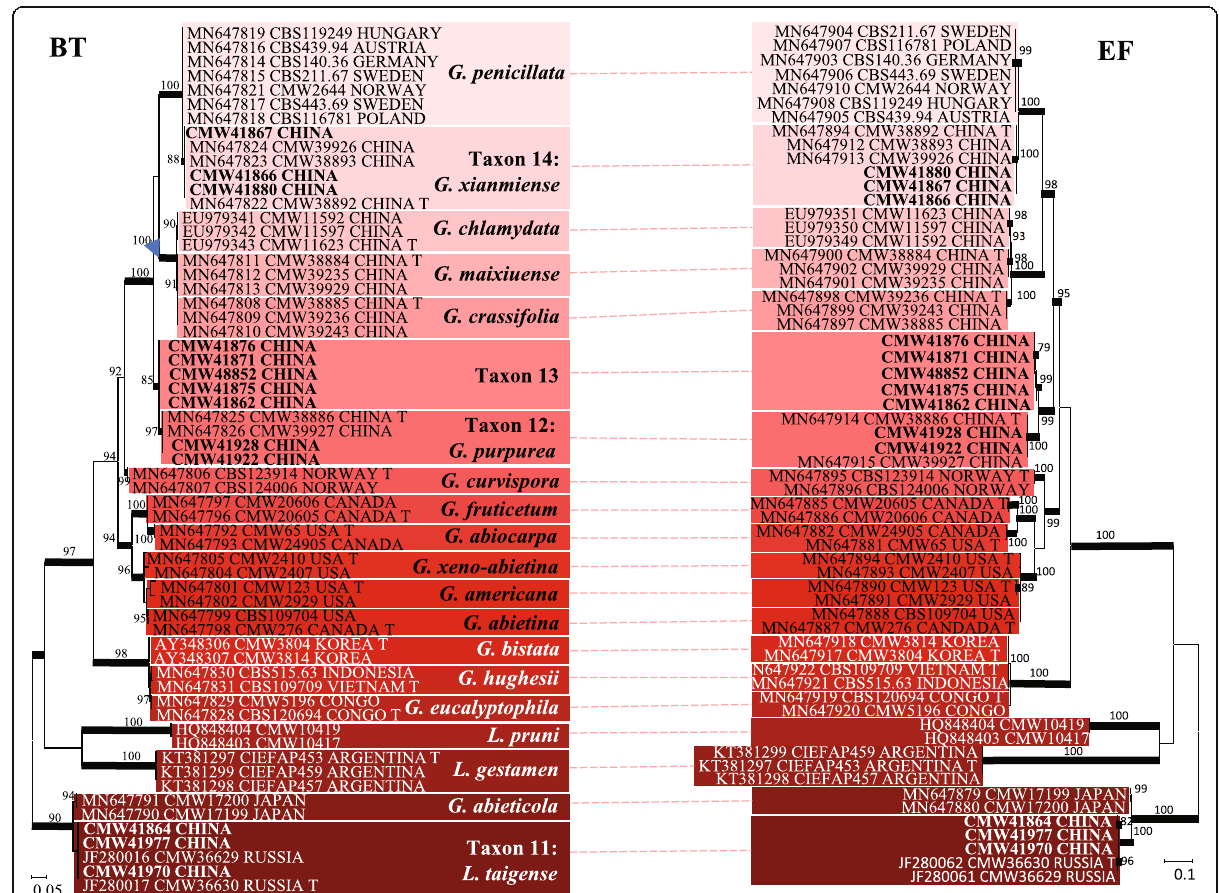
Fig. 5 Phylogram obtained from ML analyses of the partial BT and EF gene of G. penicillata complex. Sequences obtained in this study are printed in bold type. ML bootstrap support values (1000 replicates, normal type) above 75% are indicated at the nodes. Posterior probabilities (above 0.9) obtained from BI are indicated by bold lines at the relevant branching points. T = ex-type cultures. Scale bar = total nucleotide difference between